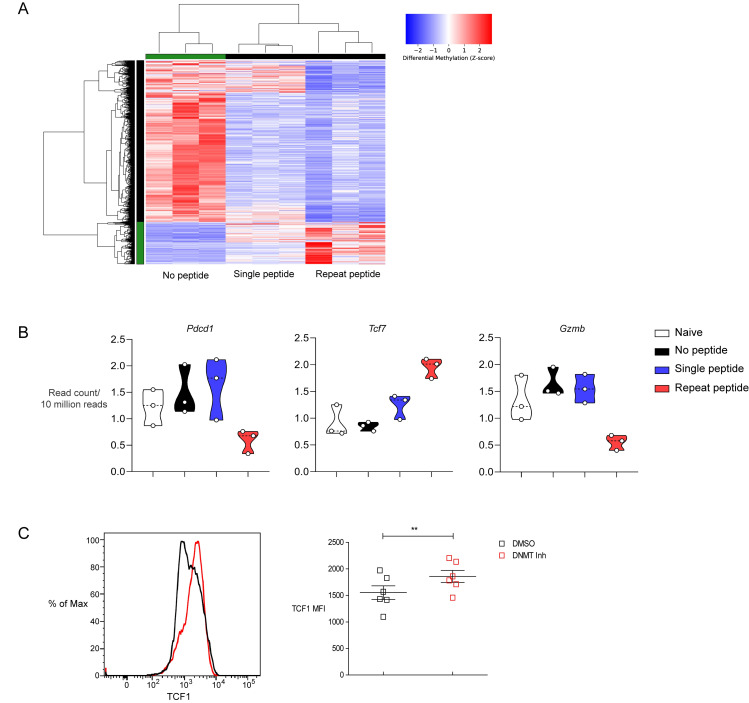
Genome wide DNA methylation changes during T cell stimulation reveal Tcf7 promotor methylation.Sorted live CD8+ T cells were processed and whole genome methylated DNA sequencing (MeD-seq) was performed. (A) Hierarchical clustering on DMRs (differentially methylated regions) found between the three different peptide exposure conditions are shown. (B) Boxplot of DNA methylation read count data in a 2kb window surrounding the TSS of mentioned genes are shown. The samples were collected from three independent experiments. (C) Representative histogram of TCF1 expression (left) and pooled data showing TCF1 MFI on live CD8 cells (right) in the presence or absence of 20μM DNMT inhibitor during the last 3 days of repeat peptide stimulated cells shown. Data are from n = 6 performed in 3 independent experiments, paired Student’s t test performed. **P<0.01.